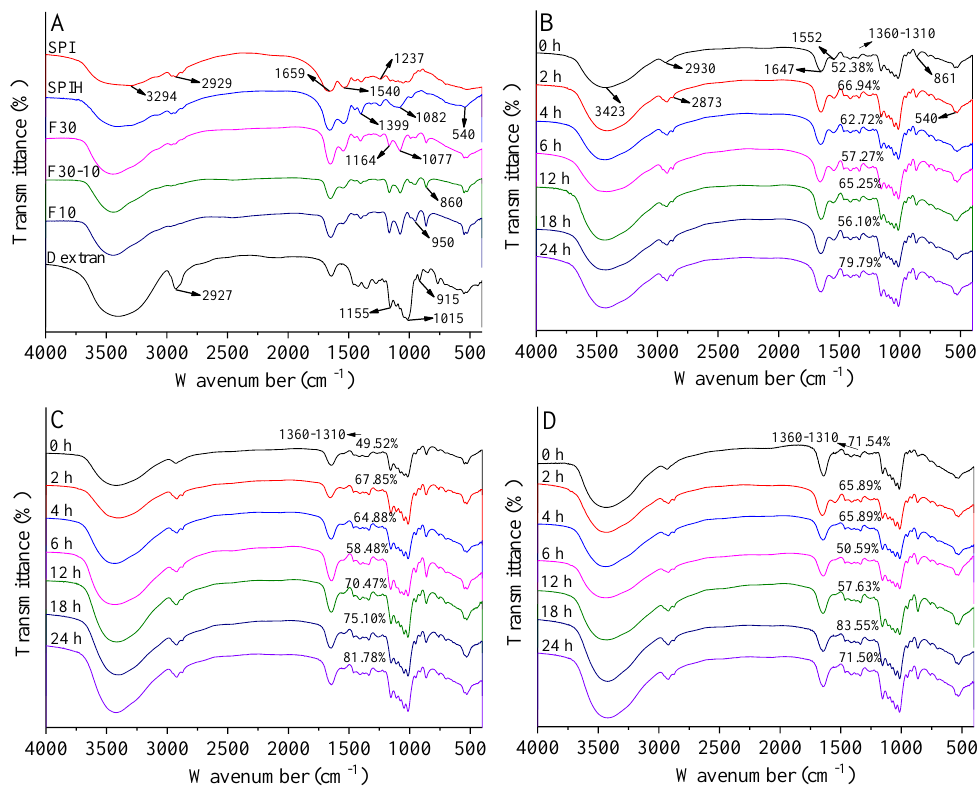
Figure 4. FTIR spectra of SPI, SPIH, F30, F30-10, and F10 ( A ); F30-dextran ( B ); F30-10-dextran ( C ); and F10-dextran ( D ) conjugates incubated for 0, 2, 4, 6, 12, 18, and 24 h. For dextran, a series of overlapping peaks (1155–1015 cm − 1 ) is mainly ascribed to the stretching vibration of C-C and C-O bonds and the bending mode of C-H bonds (Figure 4A); the absorption peak around 915 cm − 1 confirmed the presence of α -glycosidic bonds